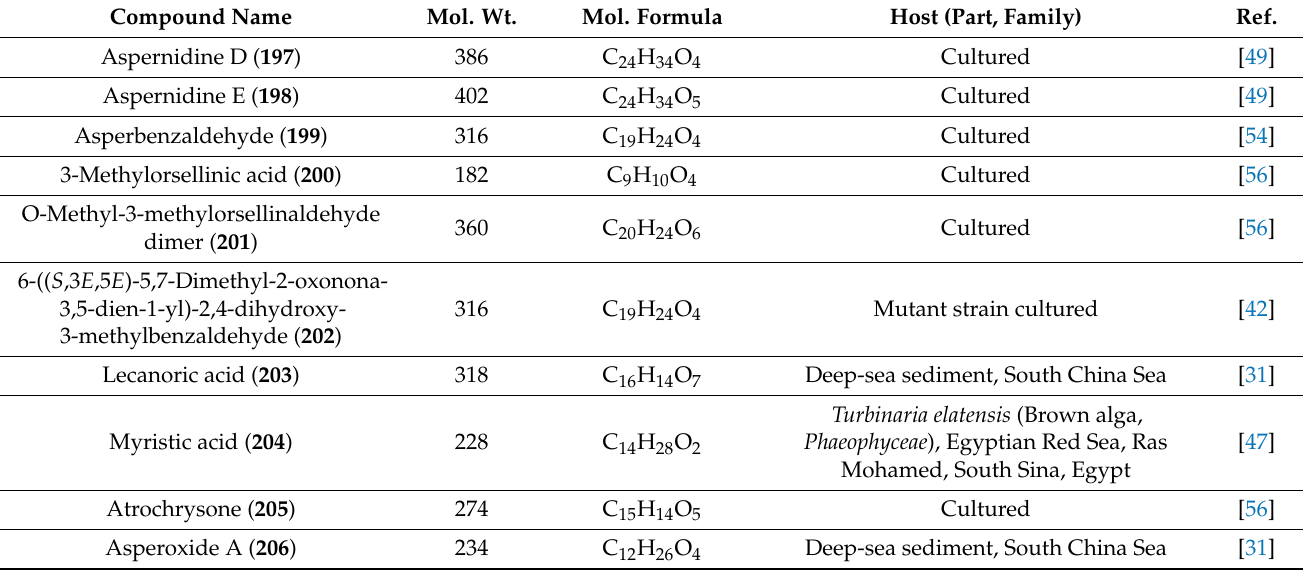
The extract of E. nidulans var. acristata displayed cytotoxic potential vs. different cell lines (mean IC 70 of 8.30 µ g/mL) [43]. A. nidulans EtOAc extract culture broth had only moderate antibacterial effectiveness vs. B. megaterium [47]. It also (Conc. 30 µ g/disc) exhibited selectivity vs. HEP-G2, compared with CCRF-CEM and CFU-GM, and potent associated A. nidulans MA-143 exhibited antibacterial and brine shrimp lethality